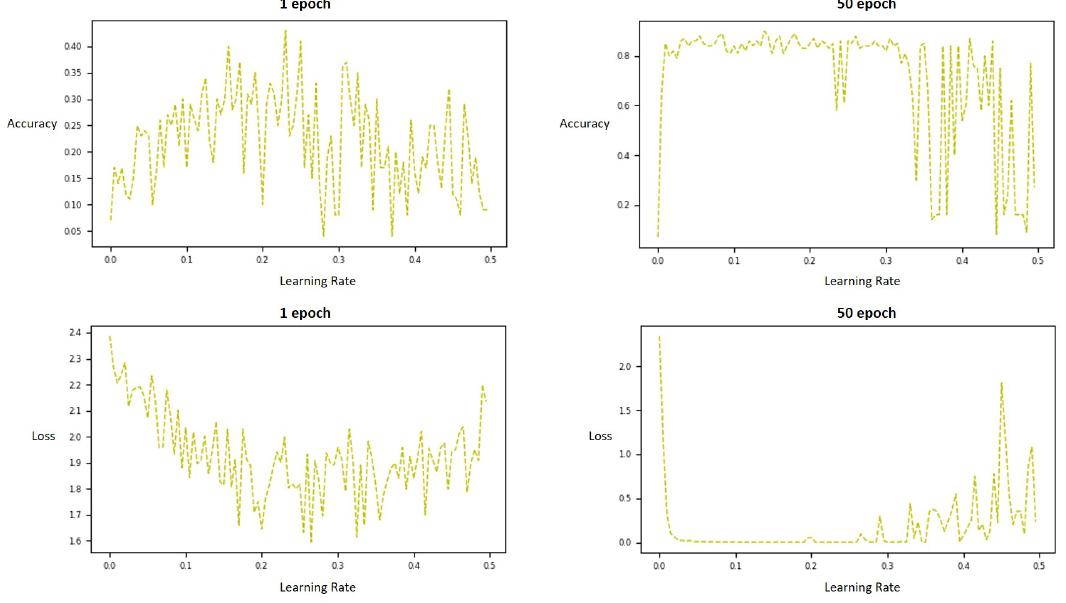
Figure 8. Estimation graph of objective function for the MNIST model. The 1 epoch and 50 epoch graphs in the top row are objective functions with accuracy as y values, and the two plots in the bottom row show the loss values.